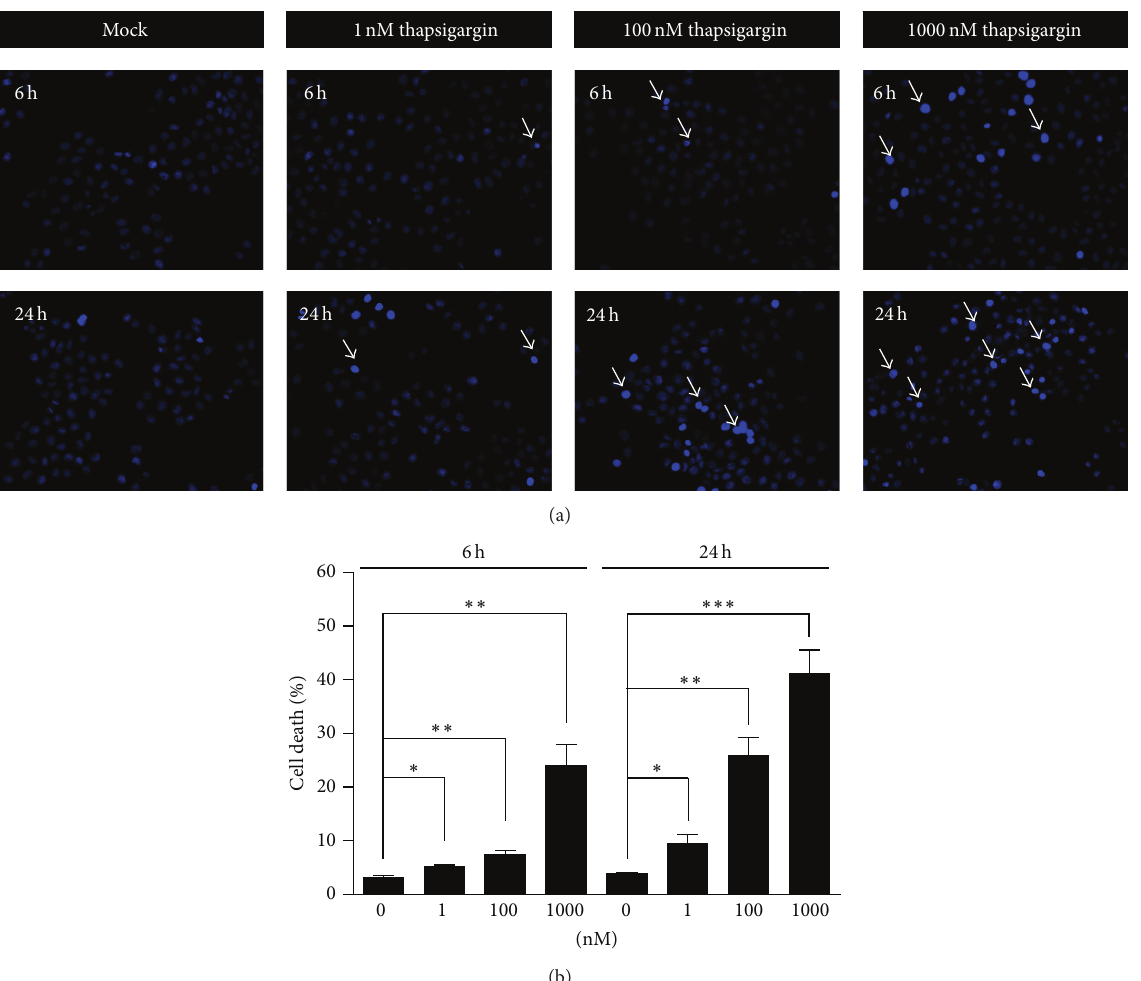
Figure 1: Thapsigargin induces cell apoptosis in A549 cells. (a) Hoechst staining (blue) showing the increasing of apoptotic A549 cells by thapsigargin (1nM, 100 nM, and 1 𝜇 M) treatment for 6 and 24 h (white arrows). (b) Histograms showing the quantification of the cell death (%) in A549 cells after thapsigargin treatment. Results are averages of three independent experiments. Data represent mean ± SEM. ∗ 𝑃 < 0.05 , ∗∗ 𝑃 < 0.01 , and ∗∗∗ 𝑃 < 0.001 .